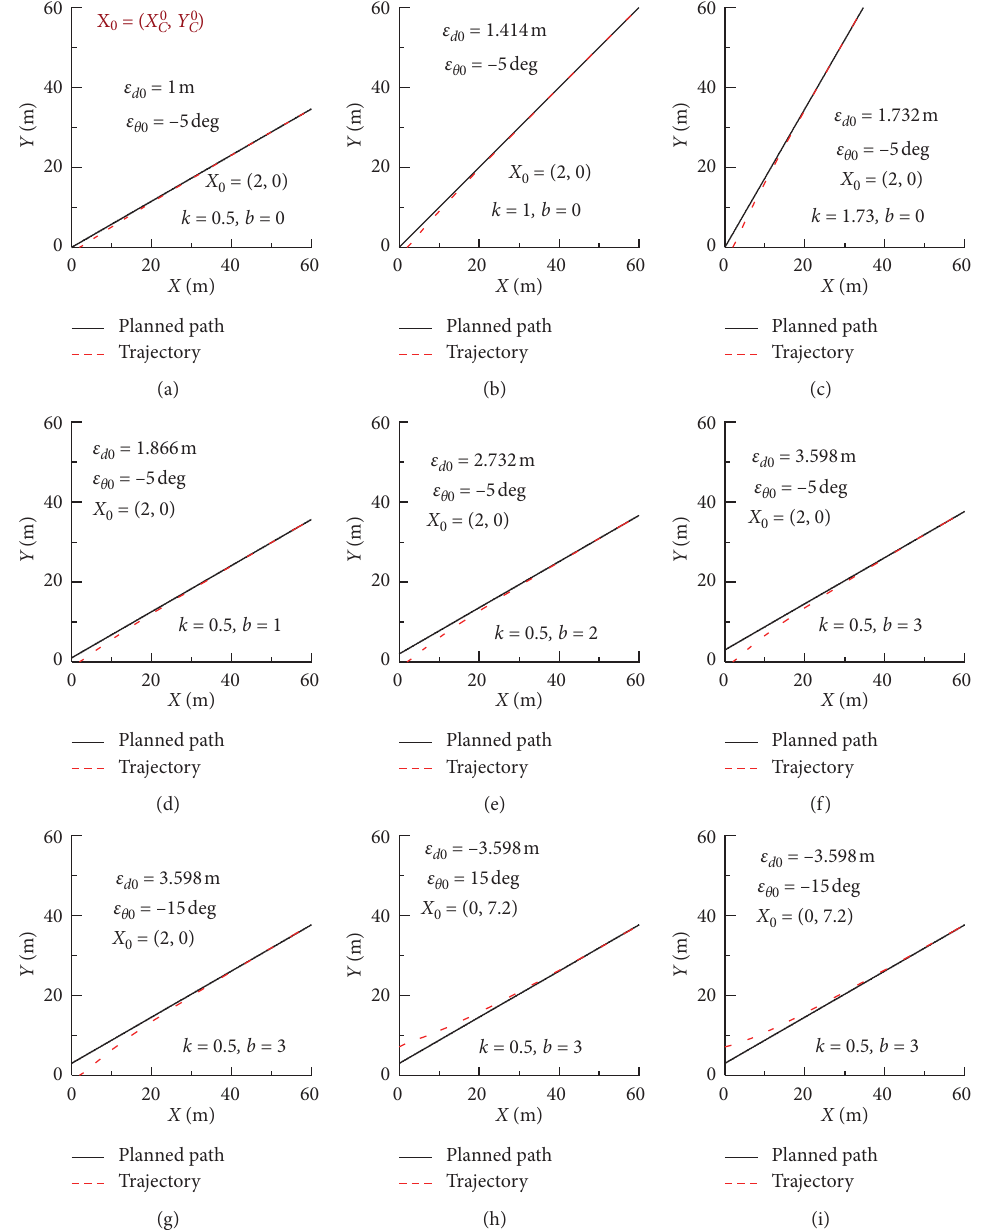
Figure 9: The straight path-following motion of the vehicle under different dynamic